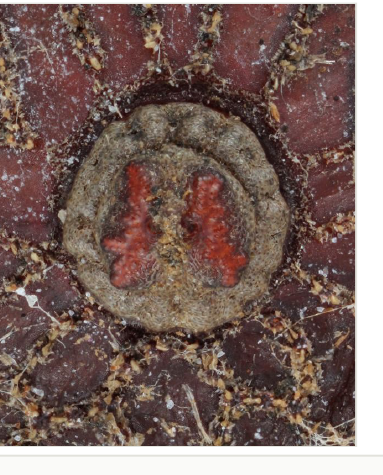
Figure 14. Posterior respiratory process, caudal view (individual No. 2).